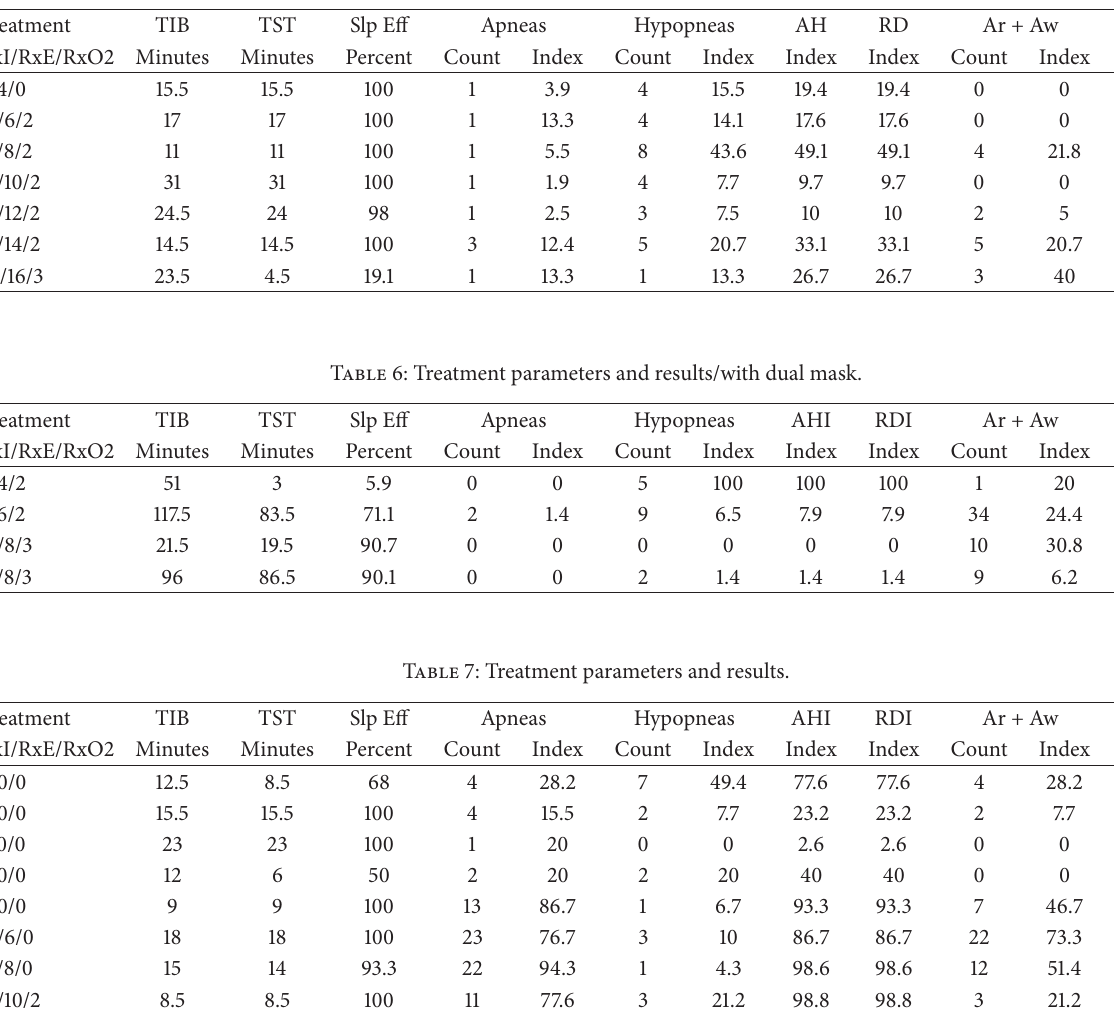
Table 5: Treatment parameters and results.